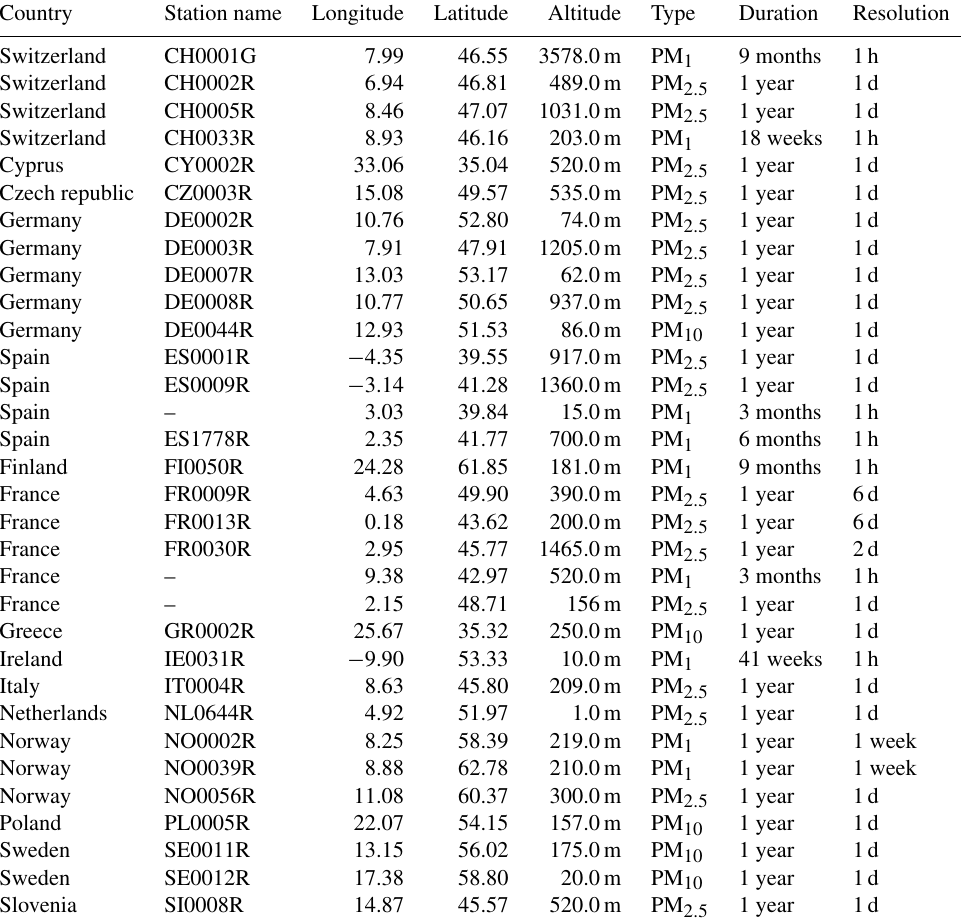
Table A1. Names and other information about the stations used in scheme validation part of this